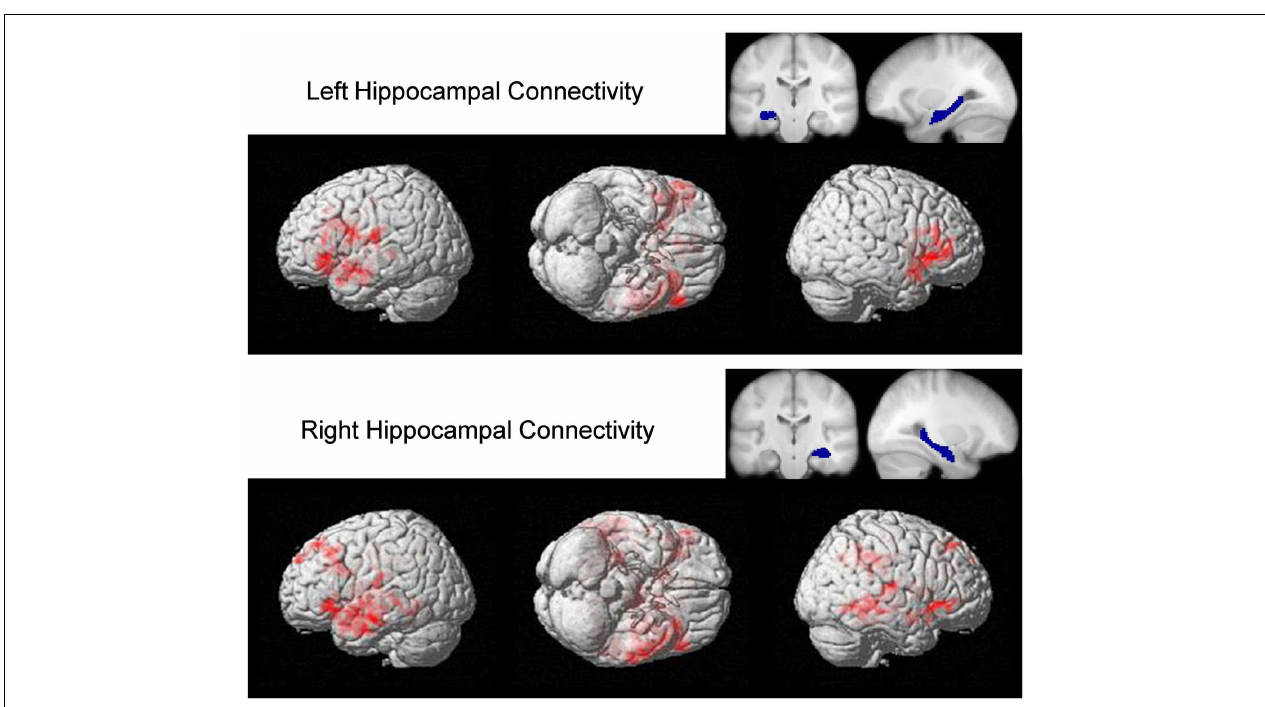
regions is displayed with corresponding blue masks). Significant clusters, displayed with red clusters, are thresholded on the voxel level at p < 0.05 with cluster size > 500.